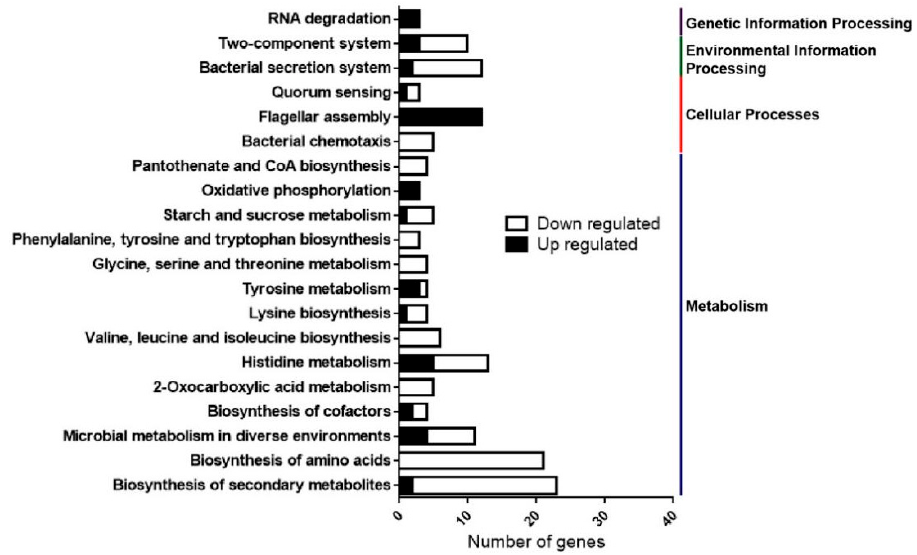
Figure 5. The Kyoto Encyclopedia of Genes and Genomes (KEGG) enrichment analysis of pathways regulated by HemK. The number of annotated genes ( x -axis) versus KEGG categories ( y -axis).